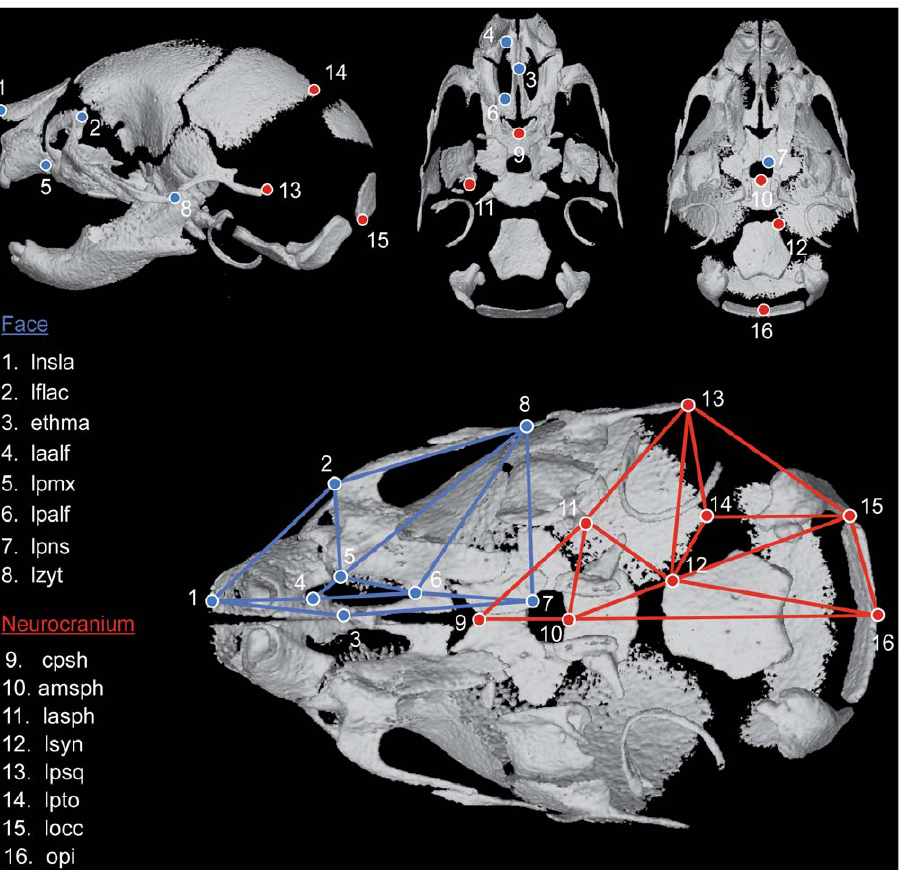
Figure 1. Landmarks collected from m CT reconstructions of P0 mouse skulls. Top: Left lateral view, superior endocranial view with vault removed and inferior view with mandible removed. Bottom: Wireframes used in Fig. 3 to display shape changes of the facial configuration of landmarks (blue) and the neurocranial configuration of landmarks (red). Codes and landmark definitions can be found in Table S1 and at our website http://getahead.psu.edu/LandmarkNewVersion/P0mouseskull_updated_applet.html.